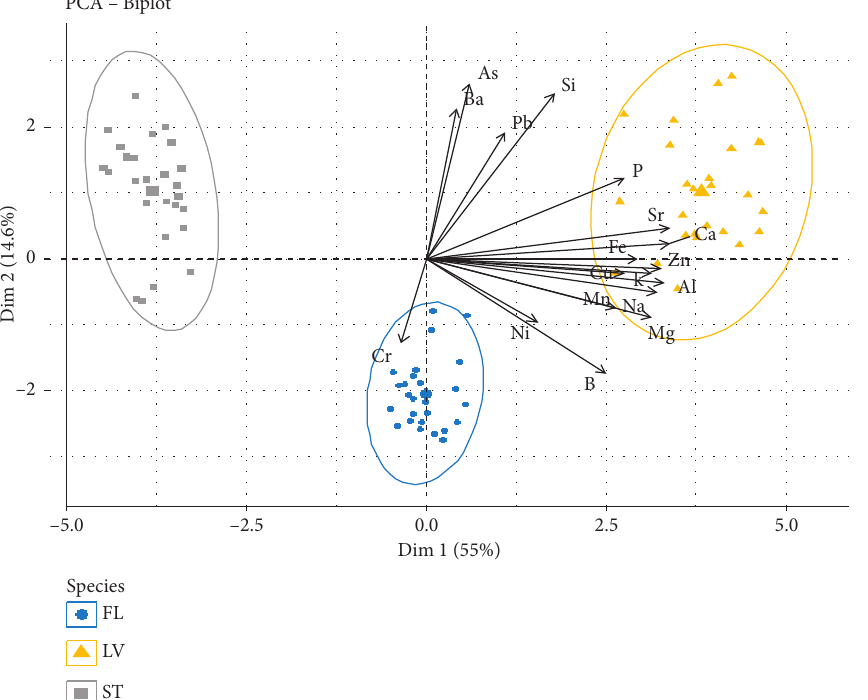
Figure 3: Superimposed representation of metals and different parts of the